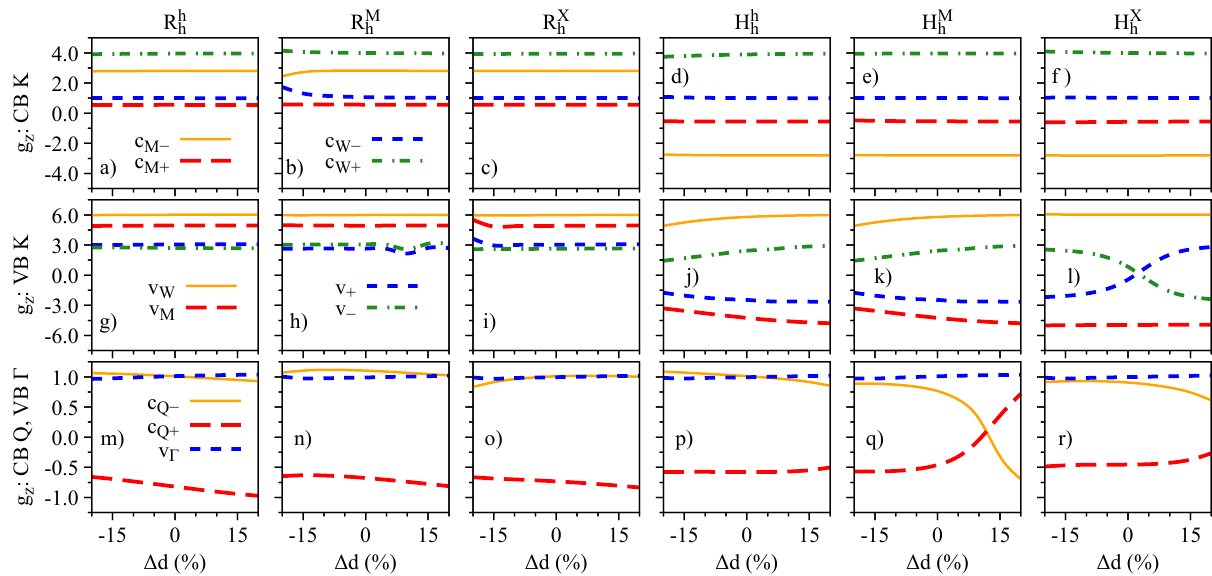
Figure 10. Same as Figure 6 but as a function of the interlayer distance